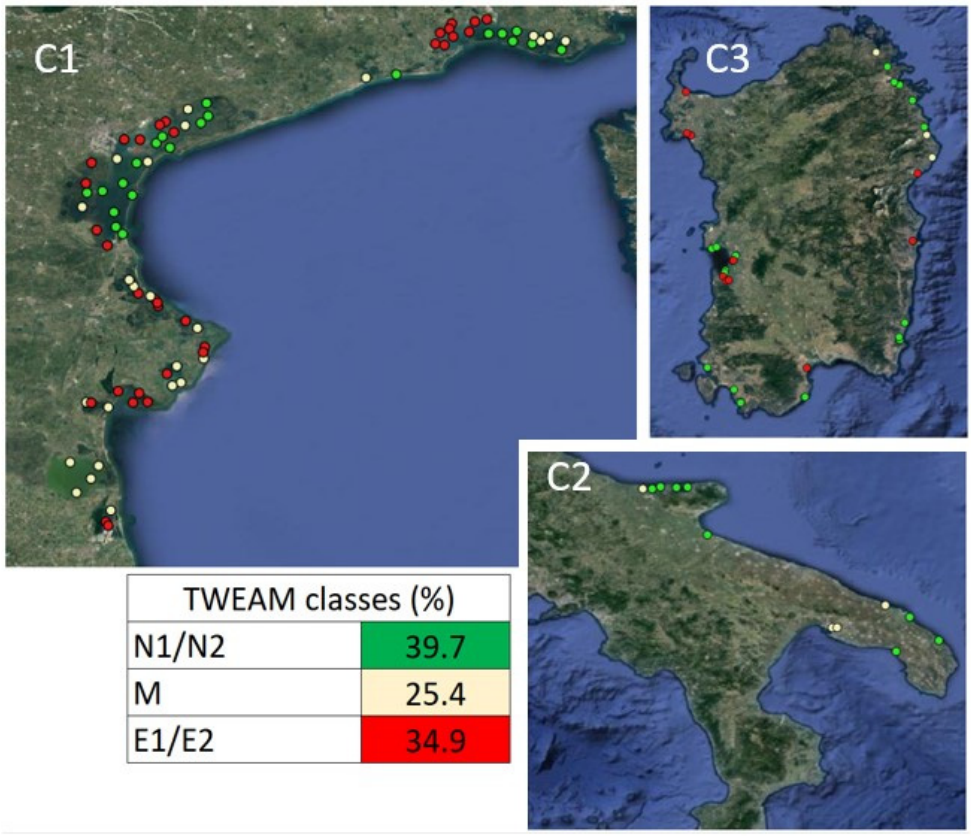
Figure 5. Eutrophic status assessment by the TWEAM method at sampled stations. N1/N2 (green dots)—not eutrophic; M (yellow dots)—mesotrophic; and E1/E2 (red dots)—eutrophic. C1: Northern Adriatic compound; C2: Apulian compound; and C3: Sardinian compound.